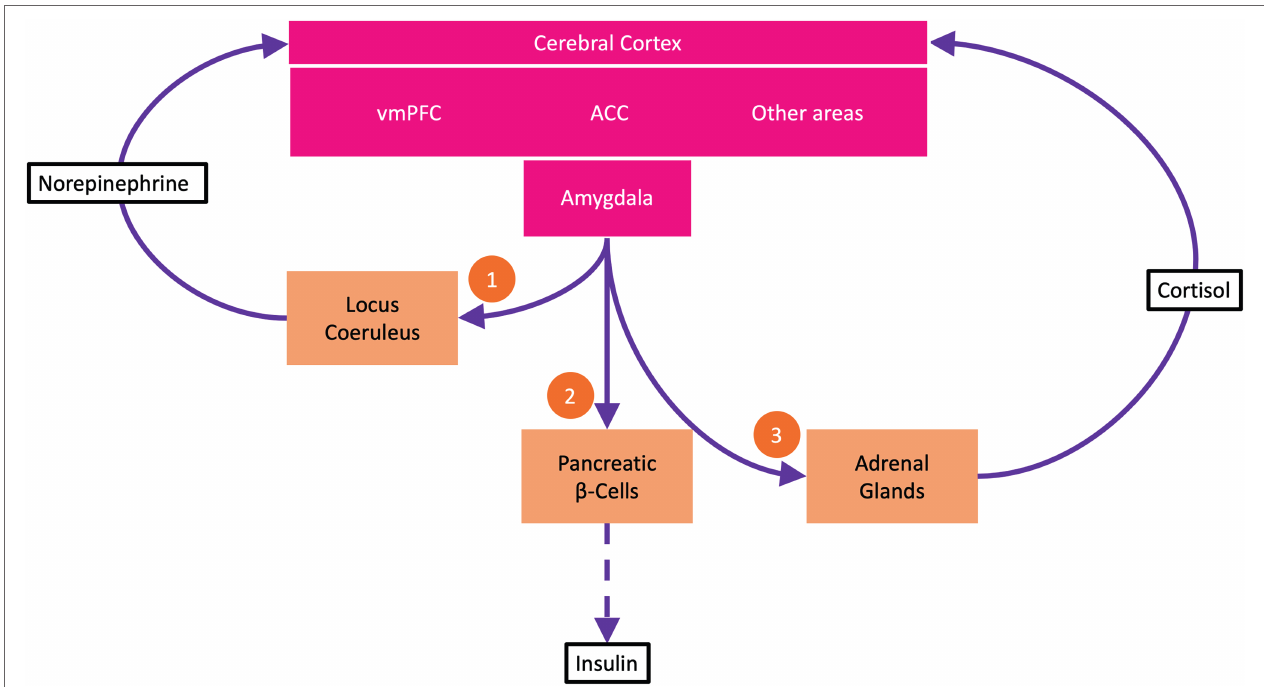
FIGURE 1 | The uncertainty resolution program (URP). The ventromedial prefrontal cortex (vmPFC) encodes beliefs about goal states. Under uncertainty, i.e., when all available policies carry a high risk of not attaining the goal states, the anterior cingulate cortex (ACC) activates the URP. The URP involves three subroutines: (1) The amygdala via descending pathways activates neurons of the locus coeruleus, which via ascending projections to the cerebral cortex release norepinephrine at cortical synapses. Norepinephrine boosts cortical information processing, making information available to reduce uncertainty. (2) The amygdala demands energy from the body to support increased cerebral information processing. Via sympathetic efferents, the amygdala strongly suppresses the pancreatic β -cells so that insulin secretion is reduced (dashed arrow). This process is called cerebral insulin suppression. At low insulin concentrations, less glucose is available to the muscle and fat tissue (which take up glucose in an insulin- dependent manner) than to the brain (which takes up glucose in an insulin- independent manner). (3) The amygdala via adrenocorticotropin activates the adrenal glands to release cortisol, which feeds back to the cerebral cortex and helps decide which uncertainty resolution measures to learn for the future and which not